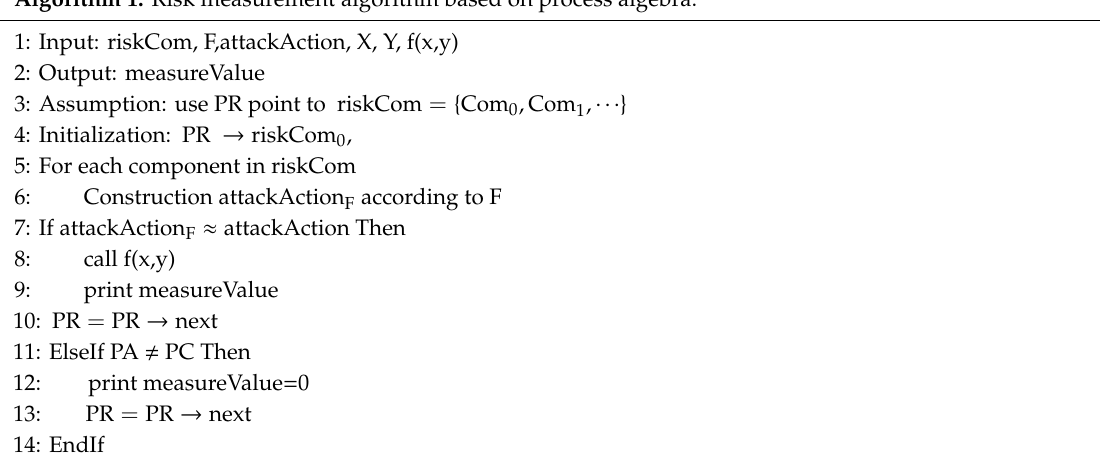
Algorithm 1. Here, riskcom is a set of components with dangerous behavior features. Algorithm 1. Risk measurement algorithm based on process algebra.